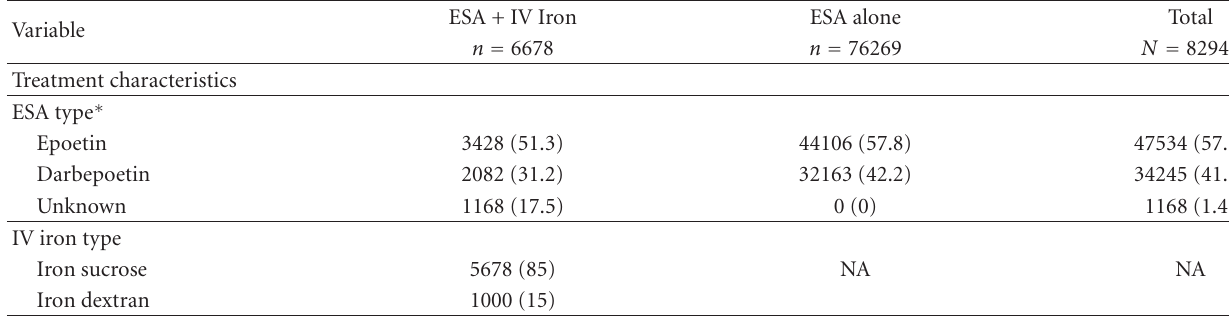
Table 5: Treatment characteristics of the study